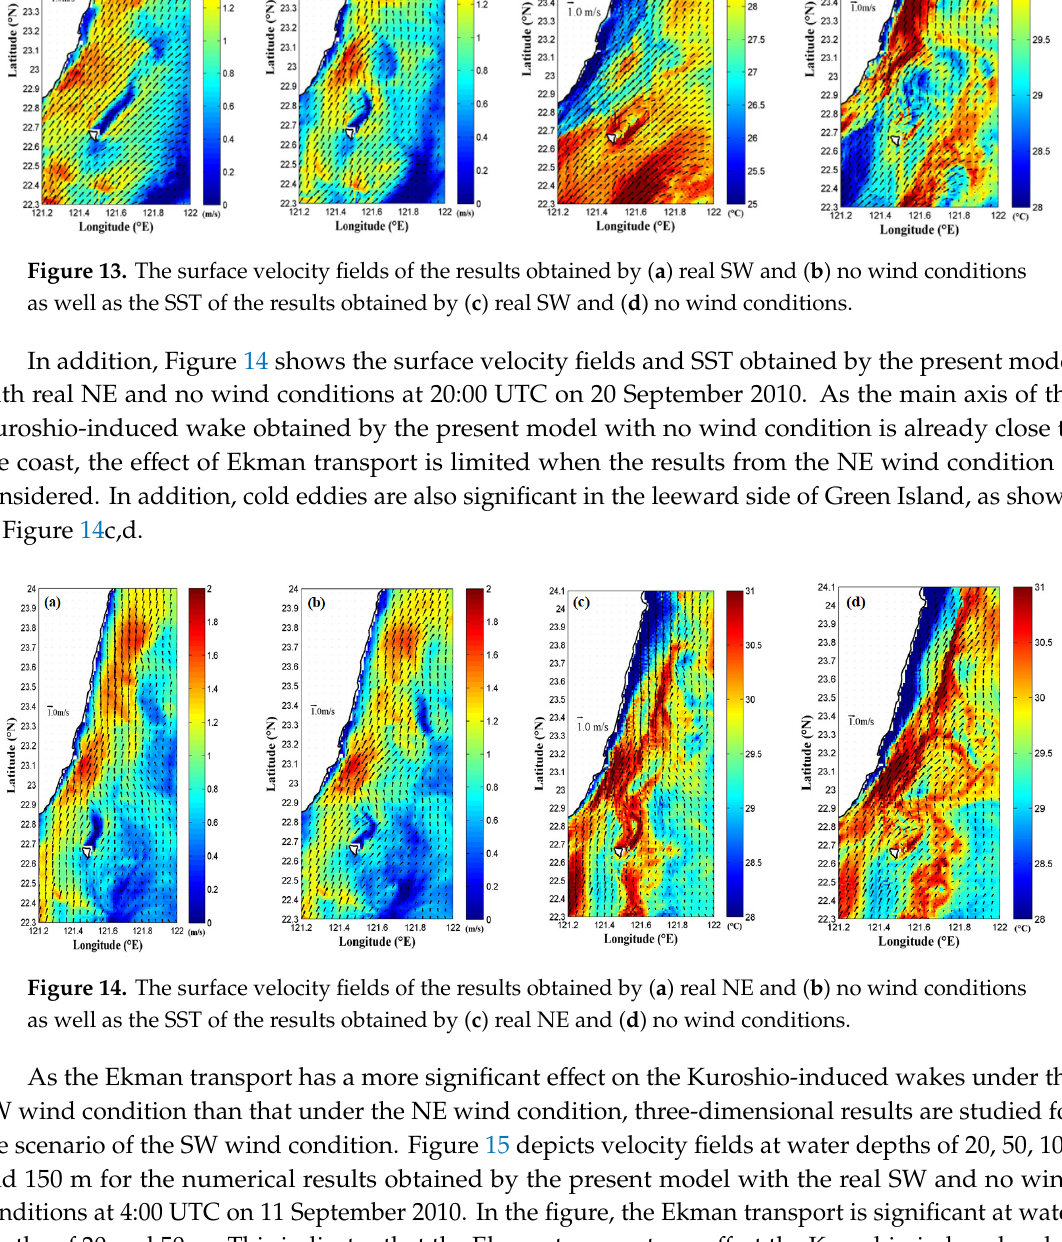
Figure 12. Velocity fields of ( a ) the SW wind condition and ( b ) the NE wind